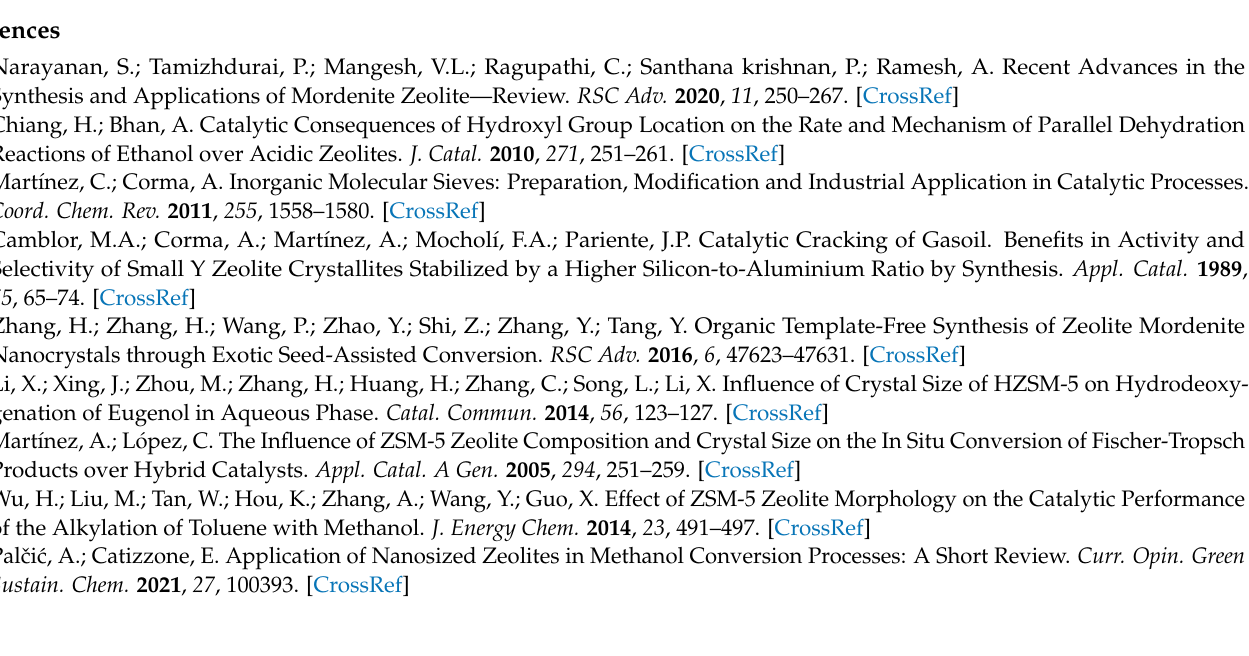
Figure A4. SEM images showing that the agglomerate of the diluted gel sample obtained at 170 °C do not aggregate in the spherical shape found in other samples ( a ) and the particles present smaller aggregation compared to the nondiluted samples ( b ).